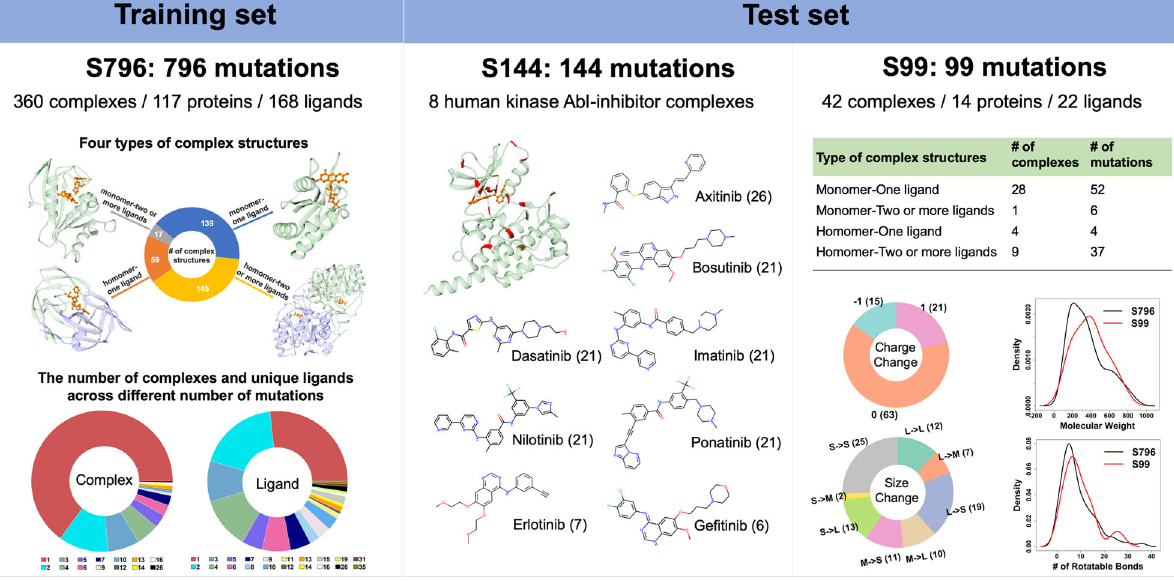
tested on the datasets of S144, S129, and S99 (Supplementary Table 4).